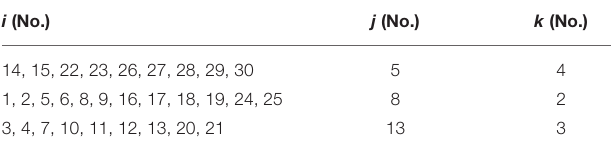
TABLE 6 | Location and allocation results according to Model 2.